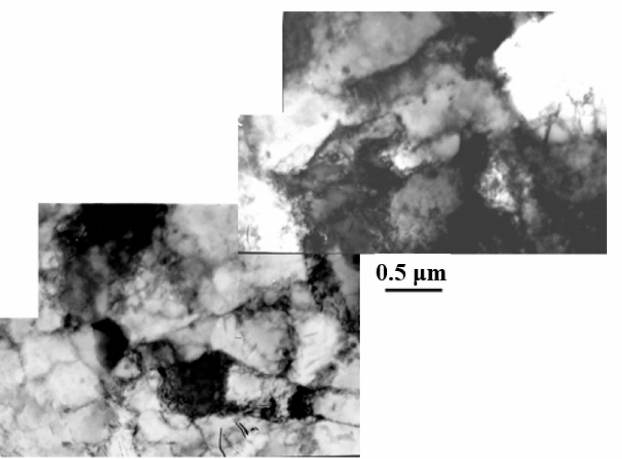
Figure 11. Sample after long-term operation to destruction, 0.12C-1Cr-1Mo-1V steel. Zone of localized deformation. Fragmented ferrite. Transmission electron microscopy.